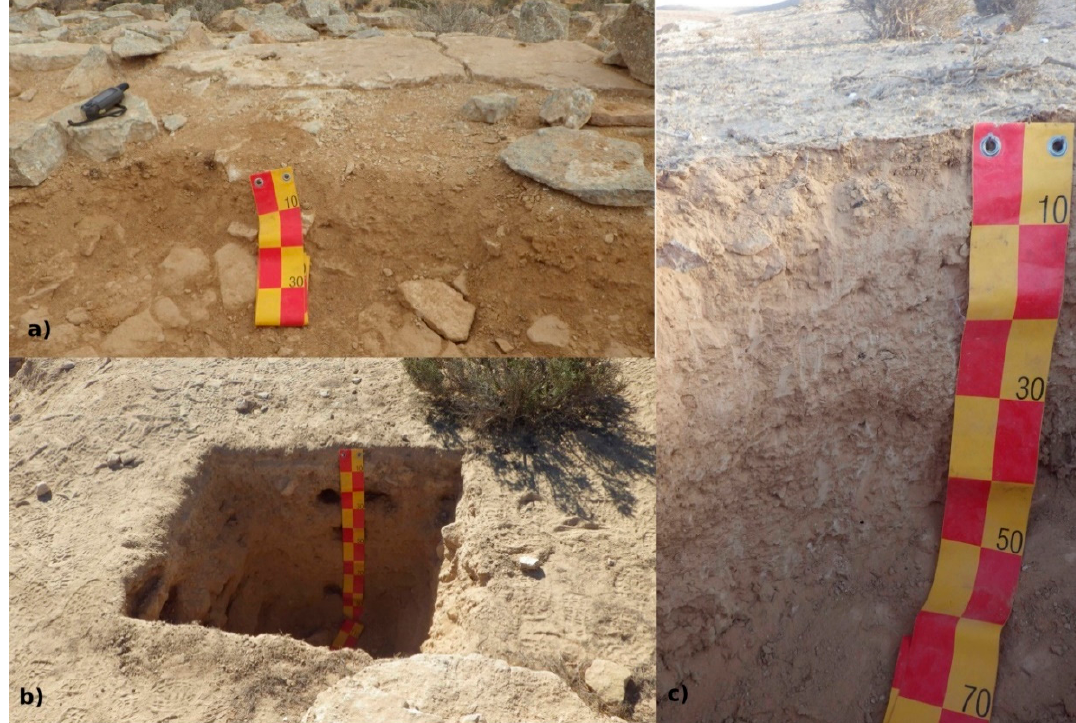
Figure 3. View from the top of Jabal Haroun to the south-west. The excavated ruins of the monastery of Jabal Haroun are visible in the center of the image and the Wadi Araba/Arava valley is in the background.